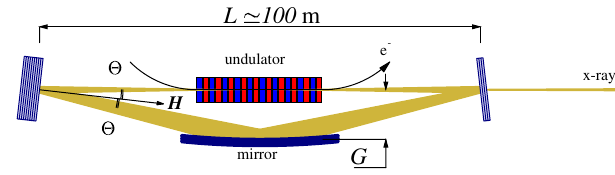
FIG. 1. (Color) Scheme of an x-ray cavity with two crystals at near-normal incidence. The grazing-incidence mirror focuses x rays onto the electron bunch e (cid:1) in the undulator and closes the loop of the x-ray path. This cavity configuration considered in [2] has a very limited tuning range, as explained in the